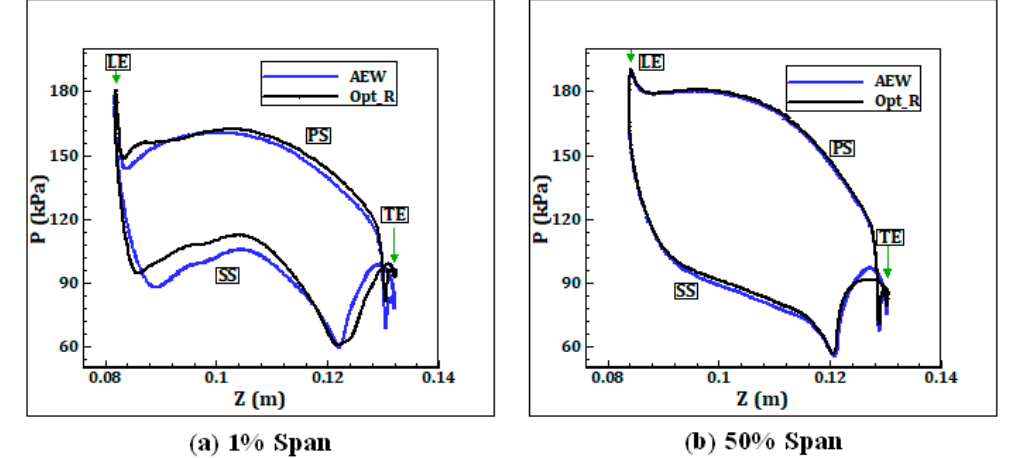
Figure 12. ( a , b ) Distribution of static pressure on the rotor blade surface. Figure 12. ( a,b ) Distribution of static pressure on the rotor blade surface.